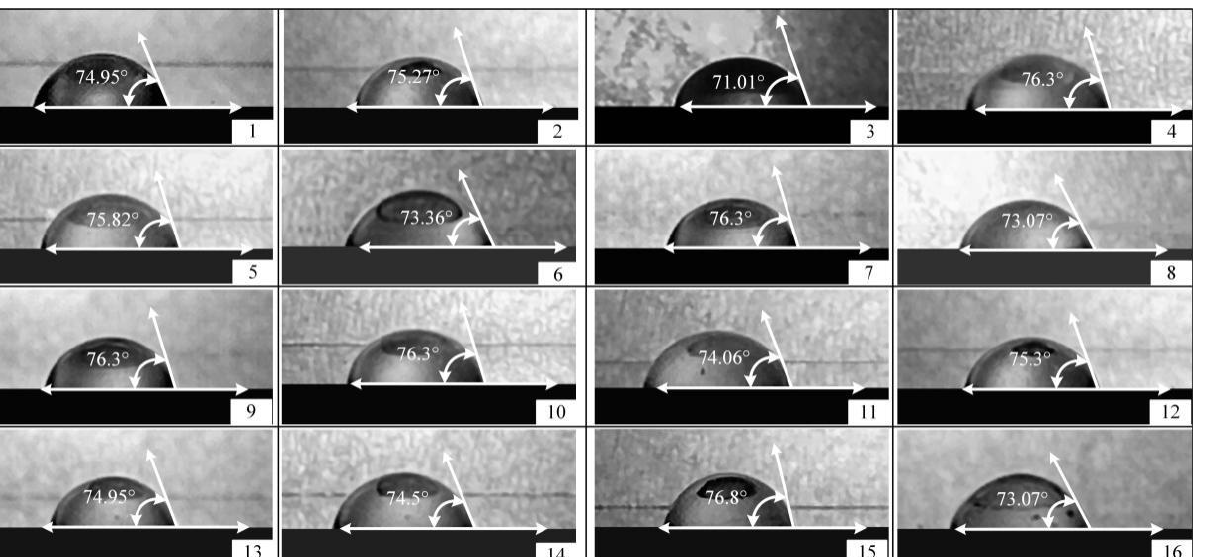
Table 1. Orthogonal experiment results ( n = 16).